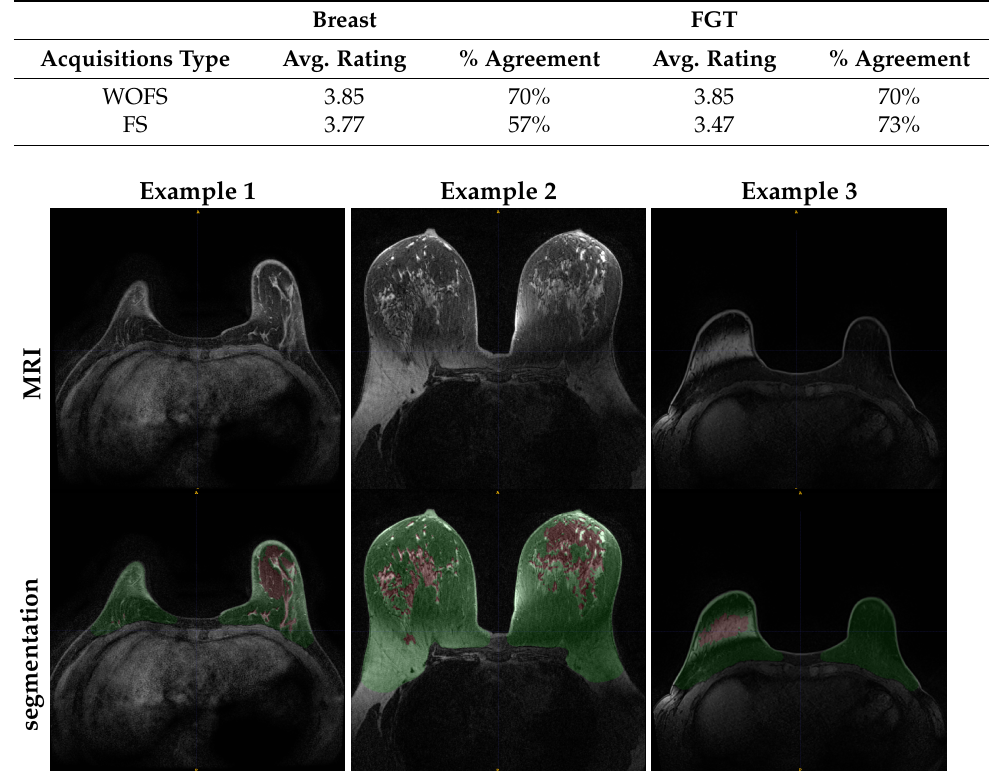
Figure 7. Example slices of FGT segmentations from external test set acquisitions rated either poor or fair during the reader study